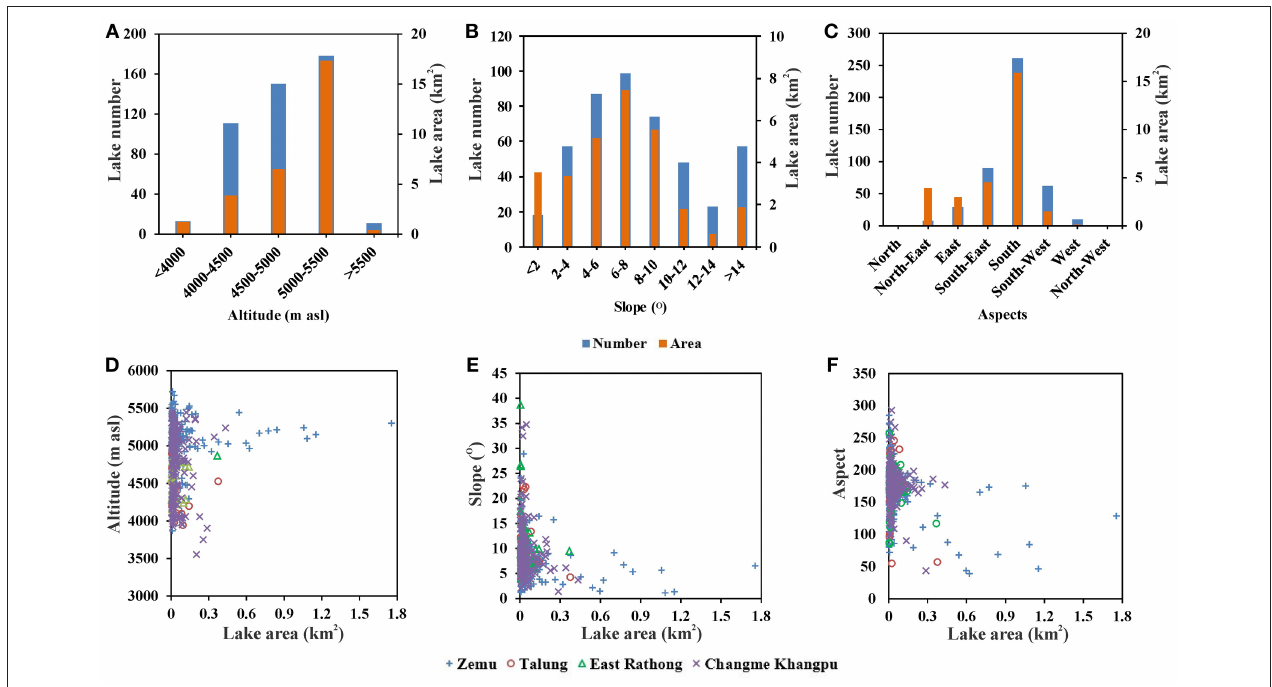
FIGURE 6 | Characteristics of lakes in 2000. Lake distribution in various altitudinal ranges (A) , Slope (B) , and aspect classes (C) . Panels (D–F) displays the altitude-wise, slope-wise and aspect-wise distributed of all the lakes located in four different basins of Sikkim Himalaya, respectively. Notice the concentration of most of the lakes in 5,000–5,500m altitude class. It can also be seen from figure that mean slope of most of the lakes is < 10 ◦ . The Southern aspect comprises of maximum number of